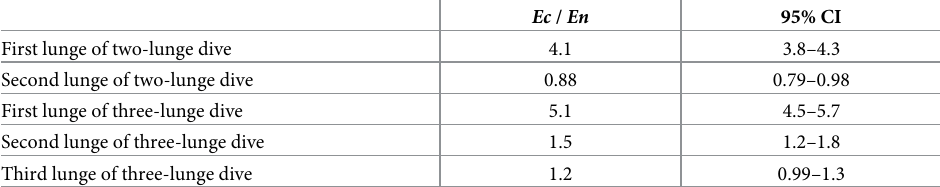
Table 2. Values of Ec / En and 95% CI for each lunge in a